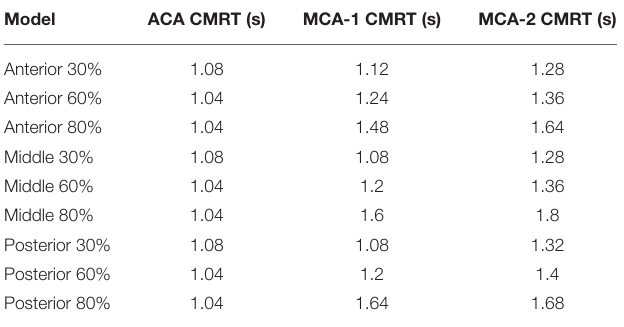
TABLE 2 | The contrast material remaining time (CMRT) for the synthetic model. TABLE 3 | The correlation between CMRT and